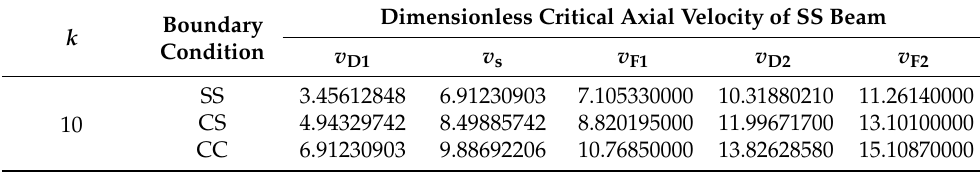
Table 5. The effects of gradient parameter k of material on the dimensionless critical axial velocities of FGM beam (SS).